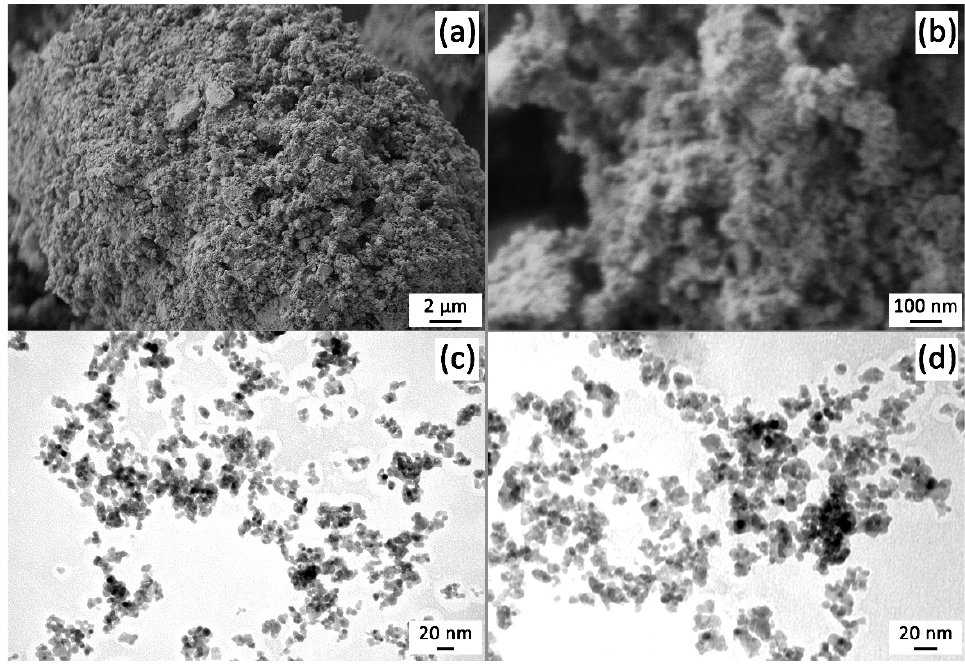
Figure 4. Microstructure of the obtained SnO 2 nanopowder: (( a , b ) SEM; ( c , d ) TEM).